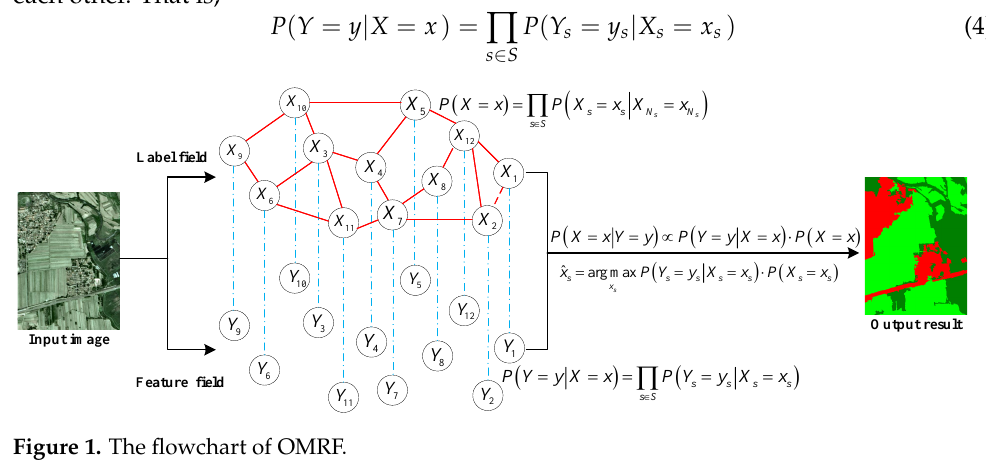
Figure 1. The flowchart of